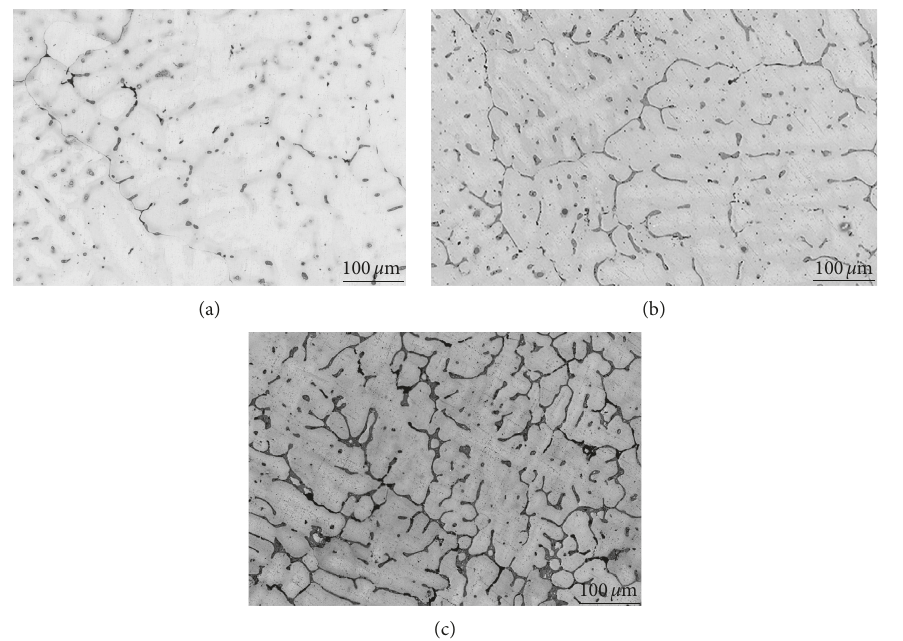
Figure 4: Optical microstructures of three Al-Cu-Mn alloys as-cast: (a) A